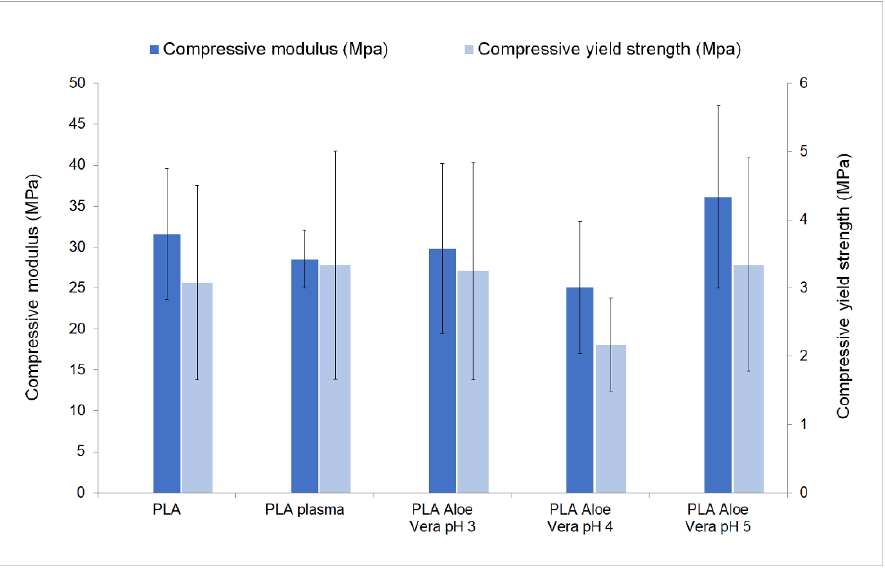
Figure 2. Mechanical properties of non-treated, plasma-treated and aloe vera-coated PLA 3D-printed scaffolds under compression testing.